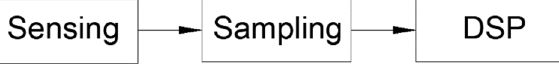
Figure 11. Basic steps of a digital measuring system using FFT.